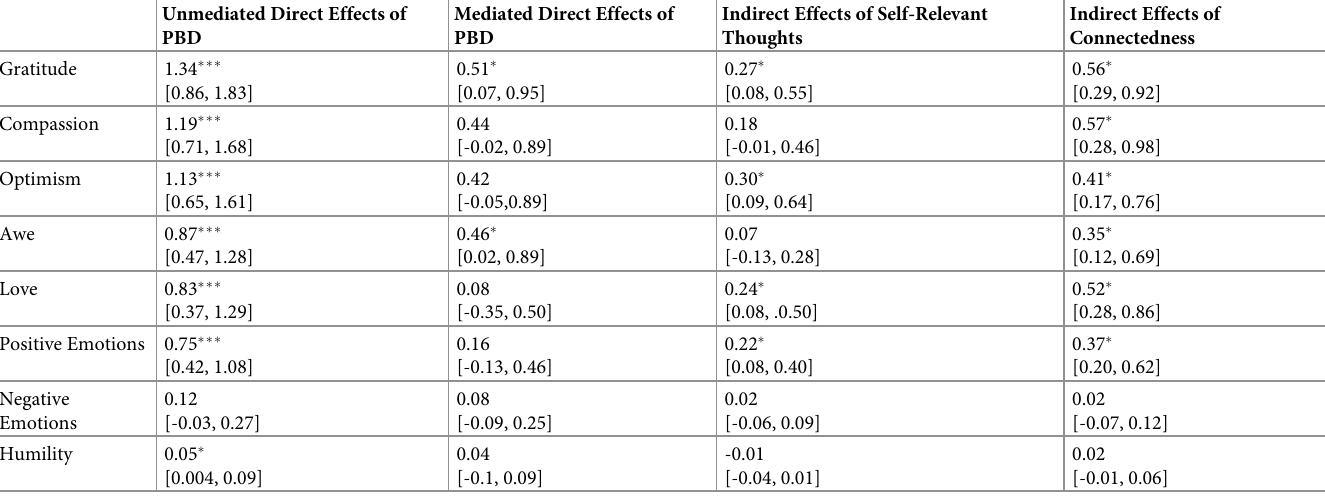
Table 2. Indirect effects of self-relevant thoughts and connectedness on emotion outcomes (Study 1).